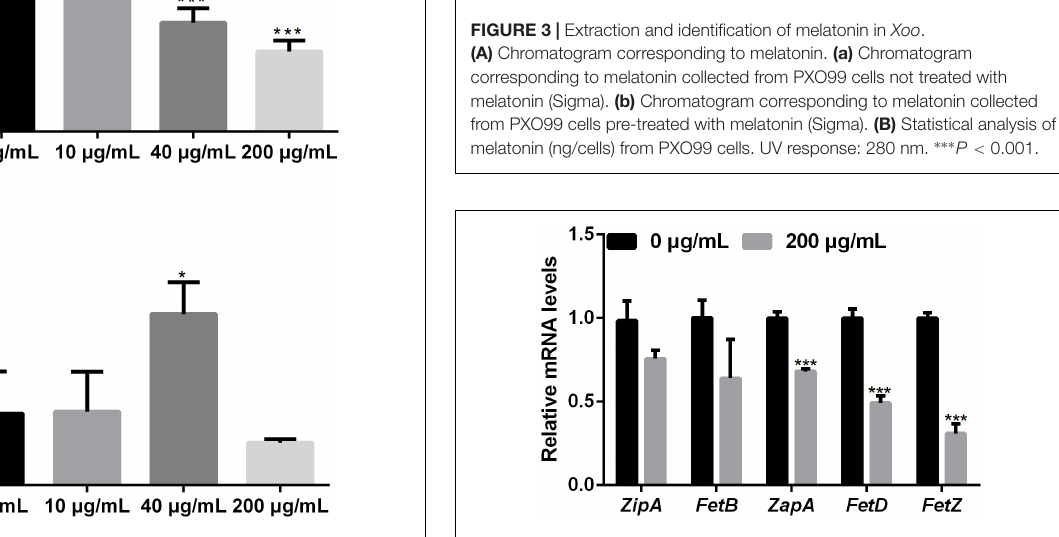
Frontiers in Microbiology |